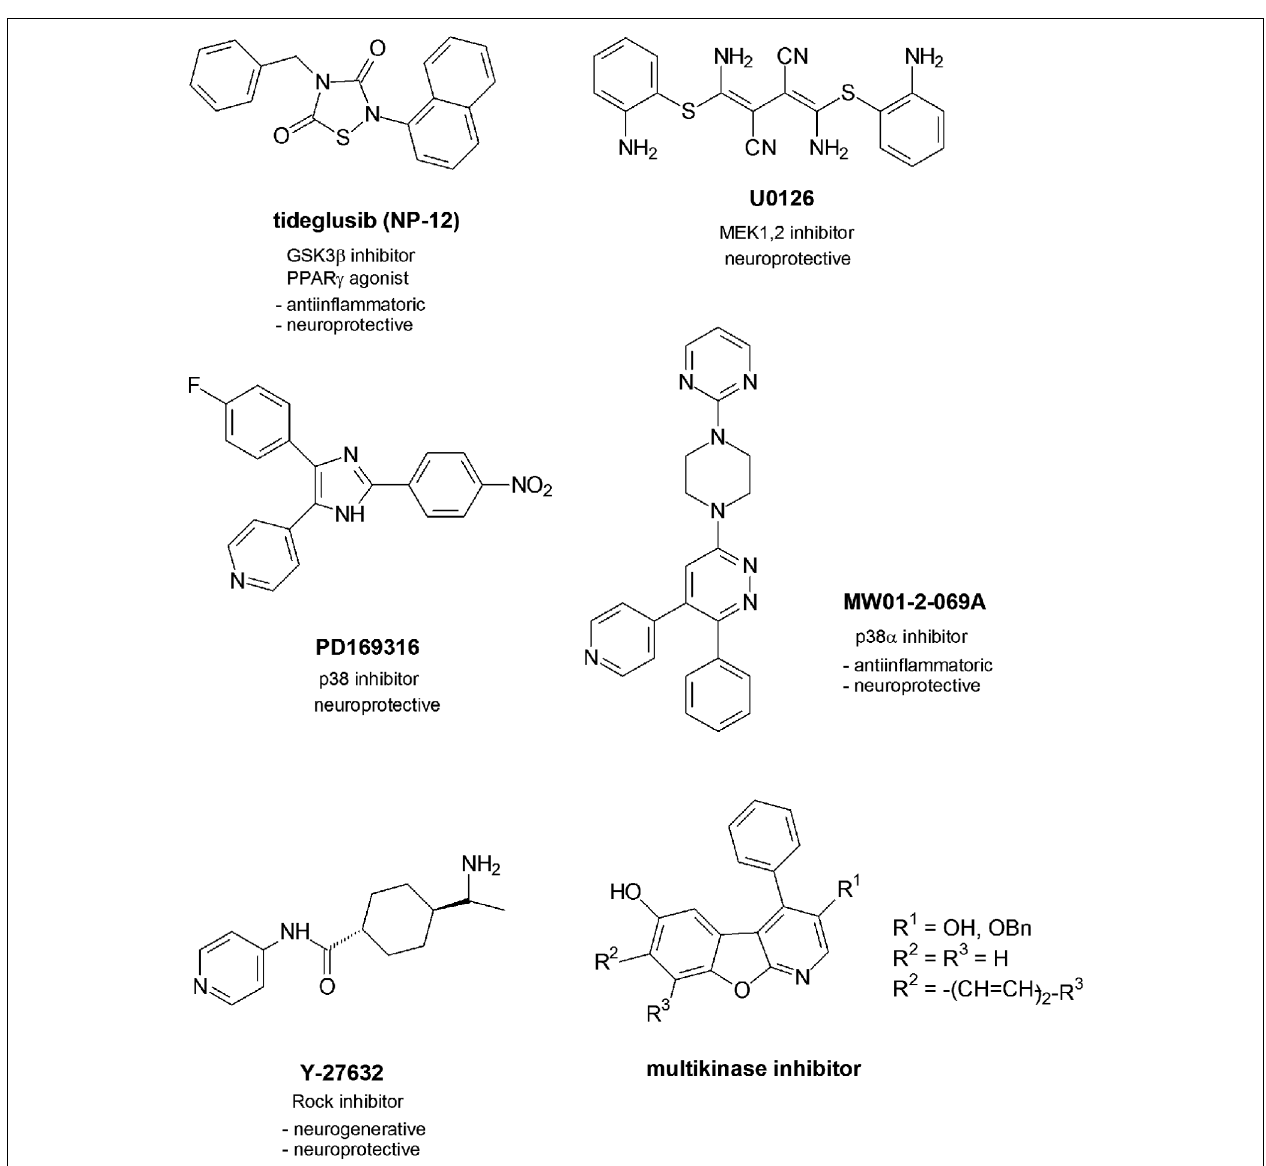
FIGURE 2 | Multitargeting